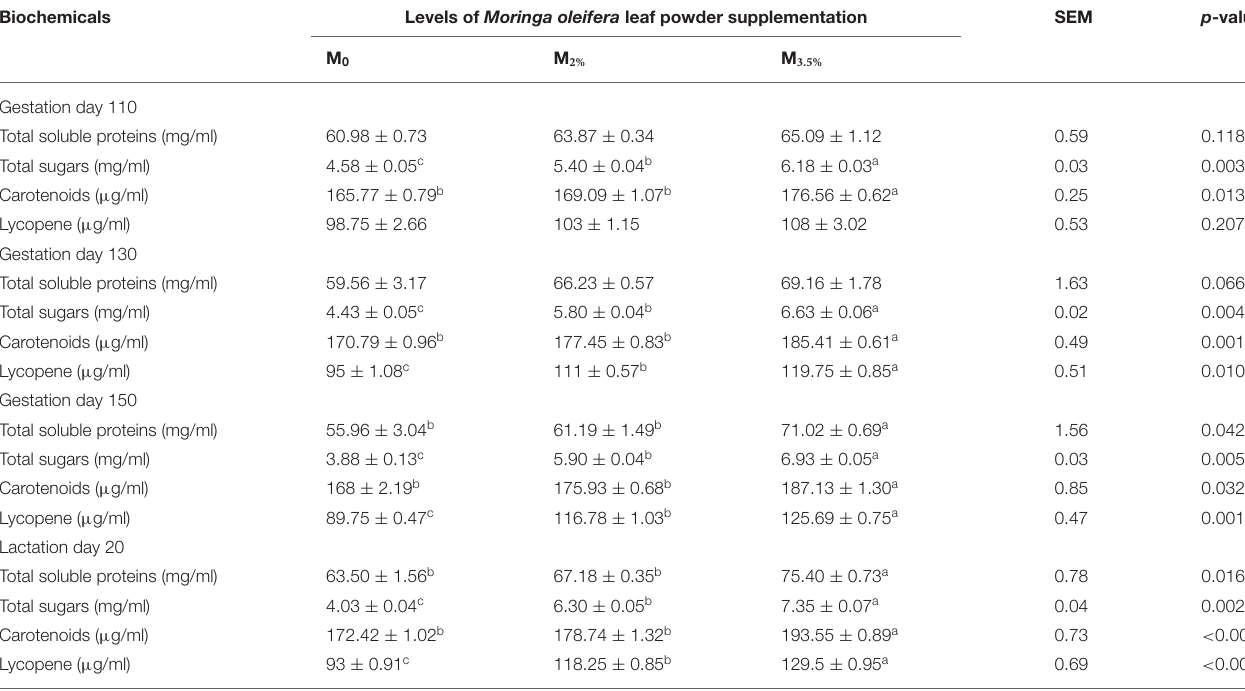
TABLE 6 | Plasma biochemical parameters of Beetal goats.